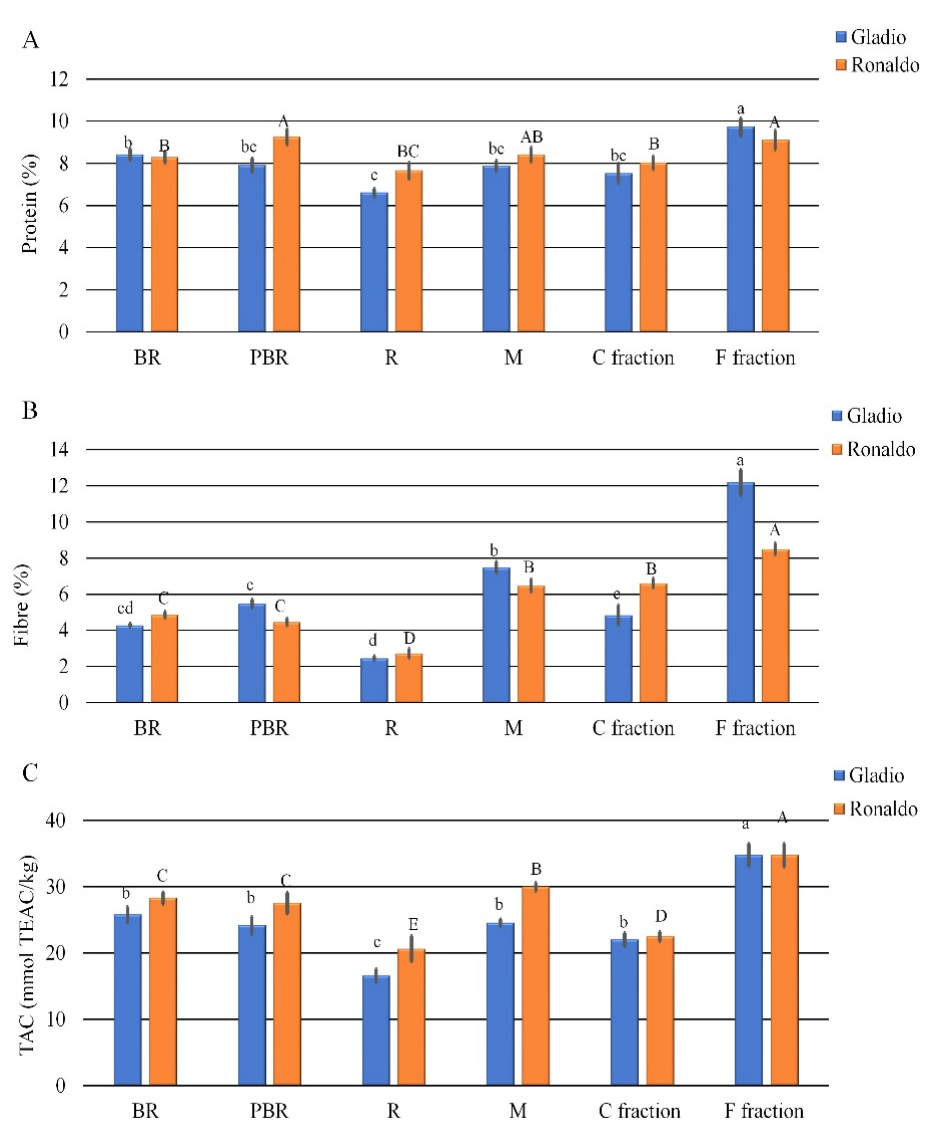
Figure 3. Protein ( A ) and fiber ( B ) content and Total antioxidant capacity (TAC) level ( C ) in raw materials of rice cultivars Gladio and Ronaldo. BR = Brown Rice; PBR = Parboiled Brown Rice; R = Refined parboiled flour; M = Micronized parboiled flour; C = Coarse; F = Fine; TEAC = trolox equivalent antioxidant capacity. Different letters indicate significant differences determined by the Mann–Whitney pairwise test ( p ≤ 0.05). Lower case letters refer to cv Gladio; upper case letters refer to cv Ronaldo. Results are expressed as ± standard deviation for three replications.